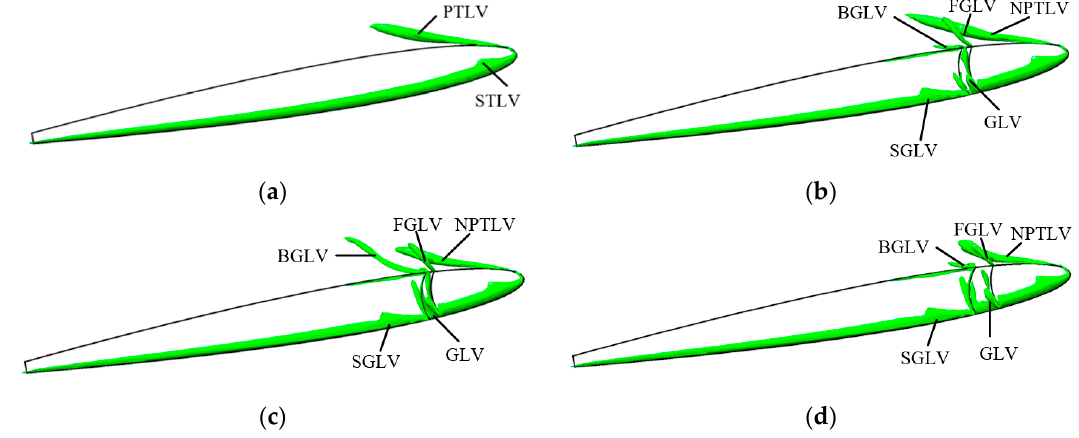
Figure 9. The vortex around the foil for different cases. ( a ) Origin case, ( b ) Case A, ( c ) Case B, ( d ) Case C.